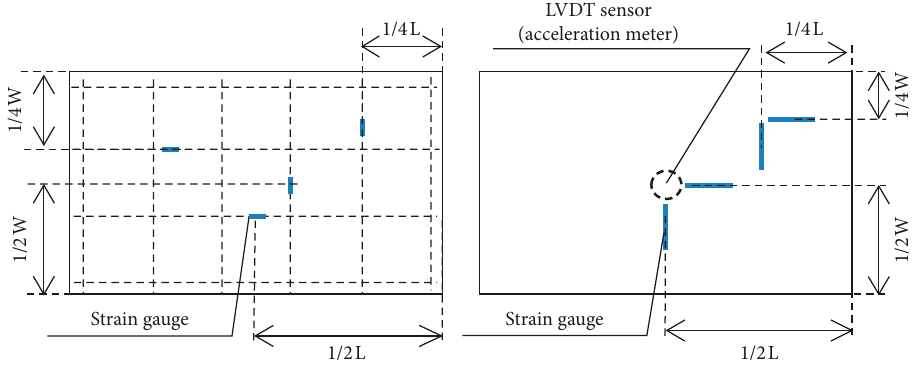
Figure 6: Measuring